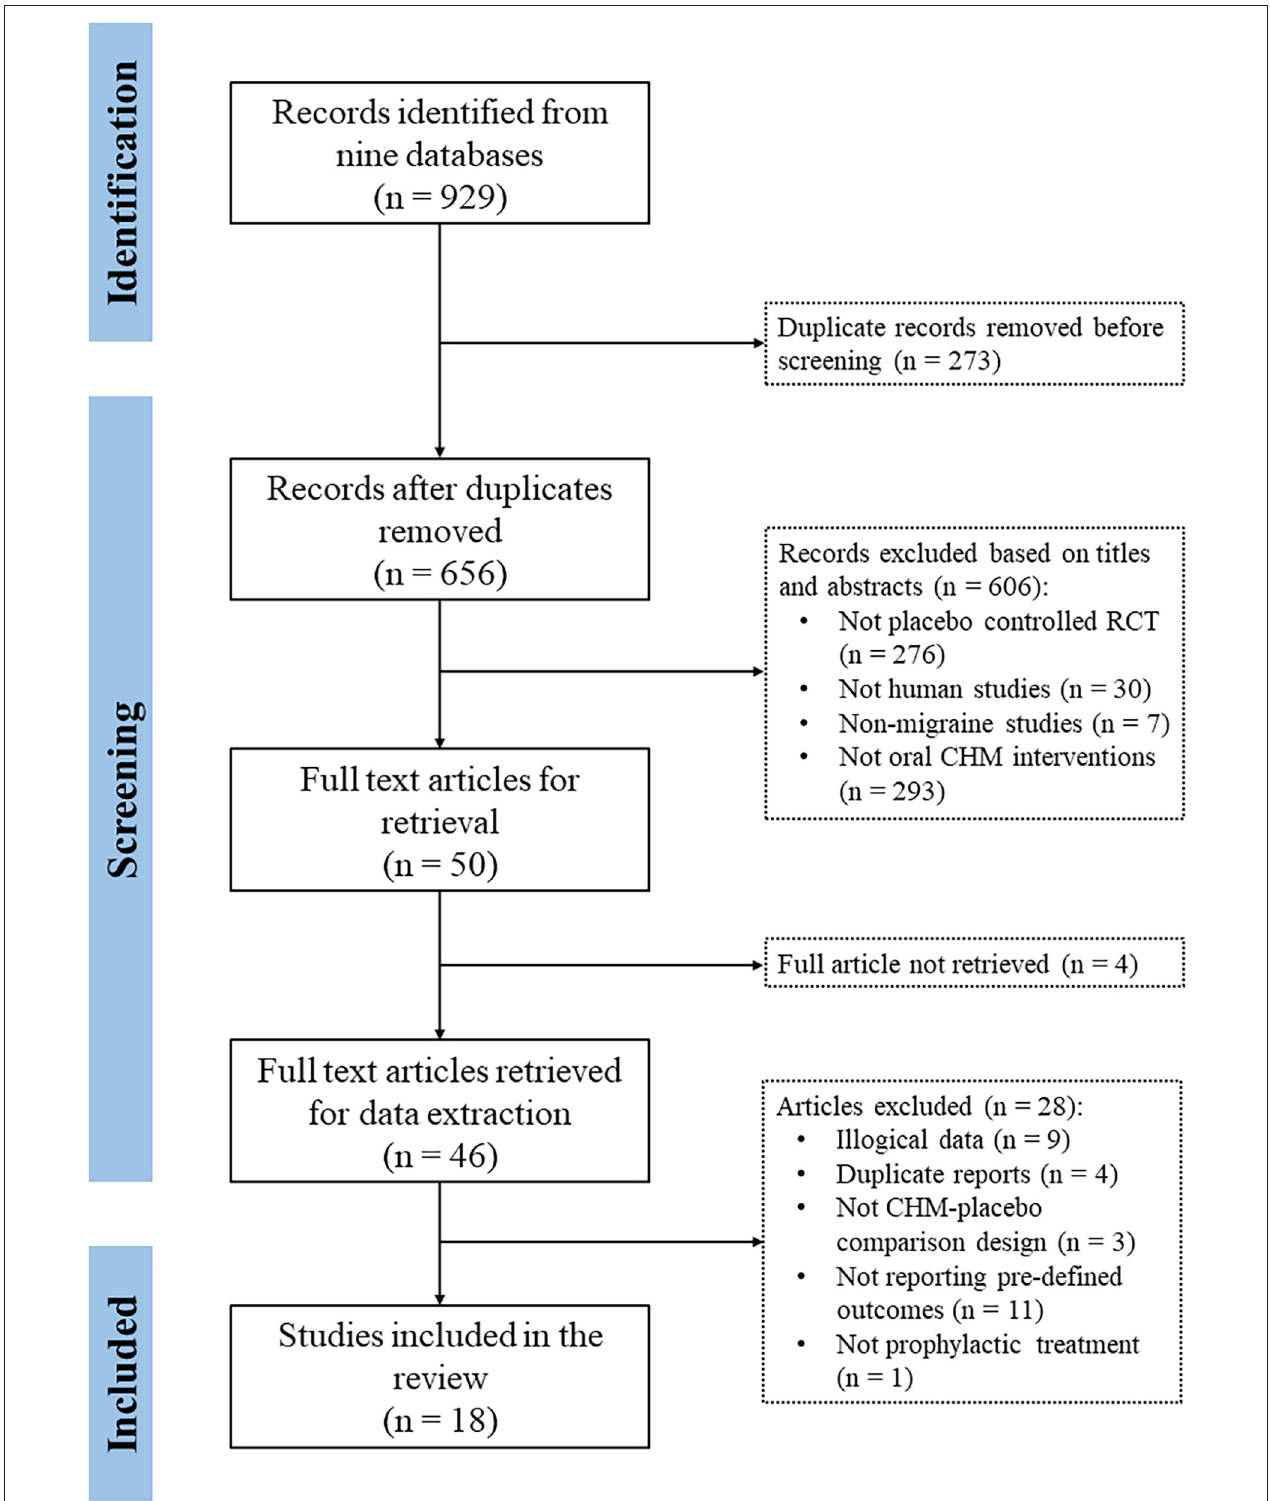
FIGURE 1 | Flowchart of the